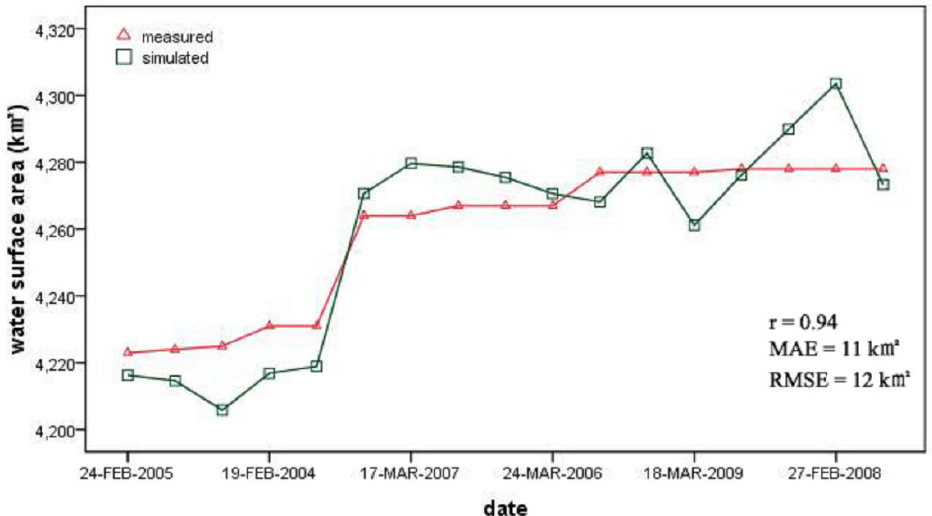
Figure 7. Comparison of the estimated surface areas with measurements. The green square represents the surface areas estimated by using the L-A equation in Figure 6 and the water levels retrieved from ICESat as inputs. The difference between Figures 5 and 7 is that the water level used in Figure 5 was adopted in the establishment of the L-A equation in Figure 6, while the water level used in Figure 7 was